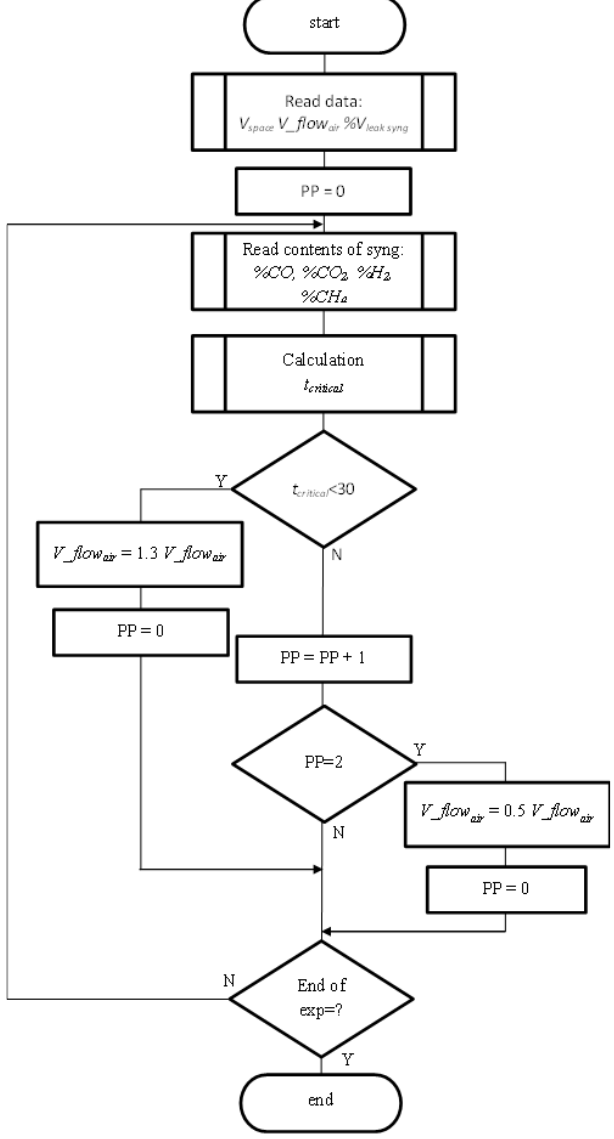
Figure 11. Control